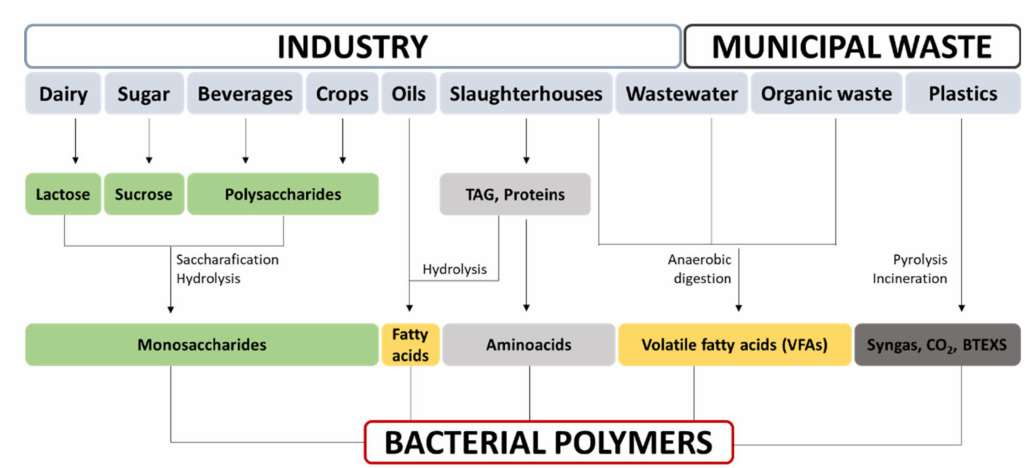
Figure 5. Flowchart of industrial and municipal upcycling of residues into bacterial polymers. Box colors indicate the highest percentage of carbon source in composition: green (saccharides), yellow (lipids, fatty acids), light grey (aminoacids), and dark grey (recalcitrant compounds: syngas, CO 2 , aromatics, and BTEXS. BTEXS includebenzene, ethylbenzen, toluene and xylene. Processes or treatments transforming the raw residues into bacteria assimilable substrates are